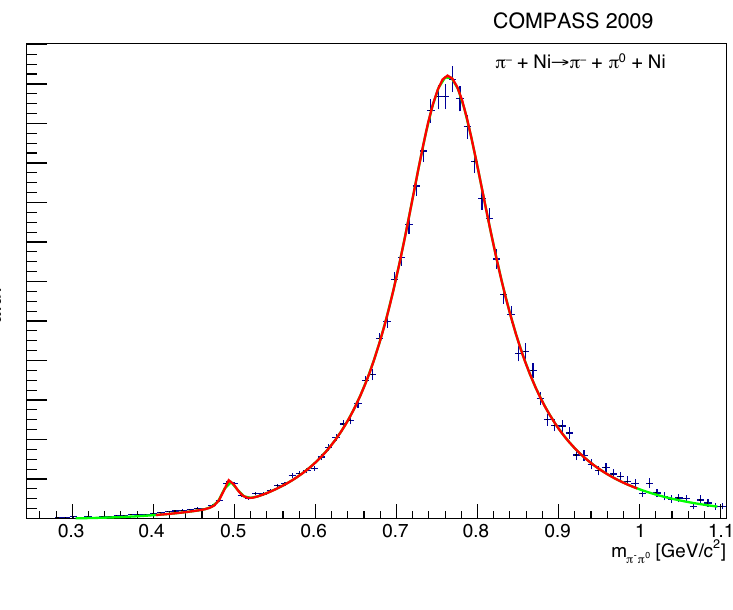
Figure 3. The invariant-mass spectrum for the π − γ → π − π 0 process after background subtraction. The shown fit according to [7] is described in the text. The vertical scale is omitted, since the determination of the luminosity of the data is still